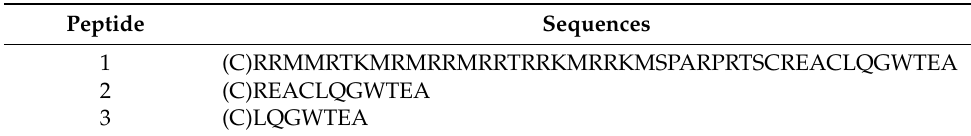
Table 4. Synthetic peptides used for immunisation. Peptides were synthesized with an N-terminal Cys to assure conjugation to the carrier.